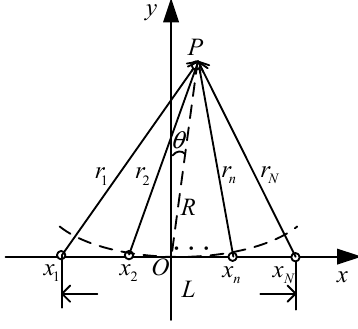
Figure 1. Near-field array model.